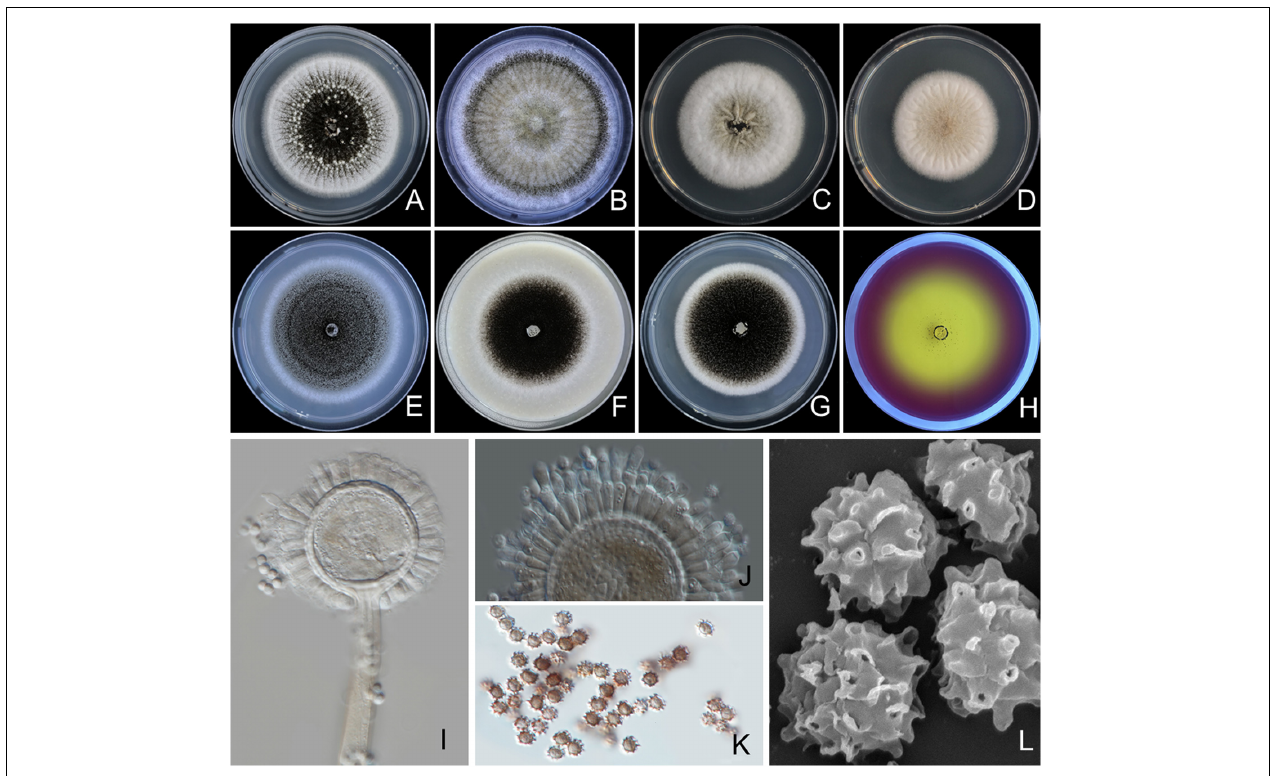
FIGURE 2 | Aspergillus chiangmaiensis SDBR-CMUI4 (holotype). Colonies incubated at 25 ◦ C for 7 days. (A) Potato dextrose agar (PDA), (B) Czapek agar (CZA), (C) Czapek yeast agar (CYA), (D) CYA supplemented with 5% NaCl (CYAS), (E) malt extract agar (MEA), (F) oatmeal agar (OA), (G) yeast extract sucrose agar (YES), (H) creatine sucrose agar (CREA), (I,J) conidiophores under light microscopy, (K) conidia under light microscopy, (L) conidia as seen using scanning electron microscopy (SEM). Scale bars: (A–H) 10 mm, (I–K) 10 µ m, and (L) 5 µ